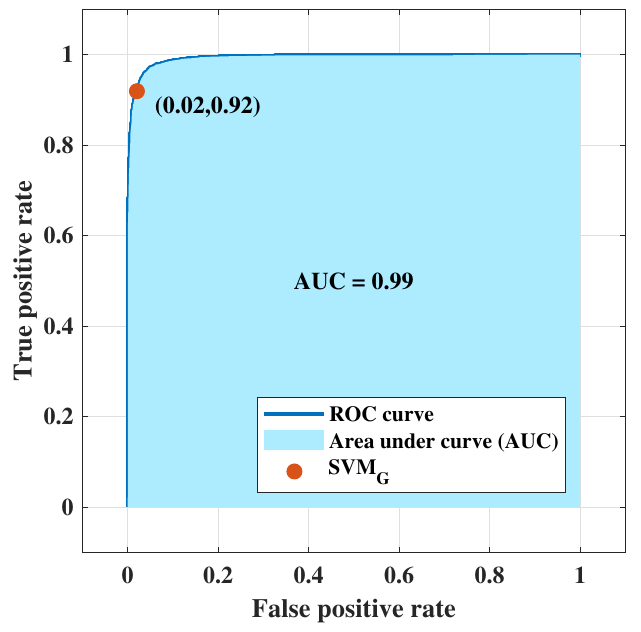
Figure 9. ROC curve obtained from SVM G employing principal components of real parts of S 21 signals for NF-WF signal